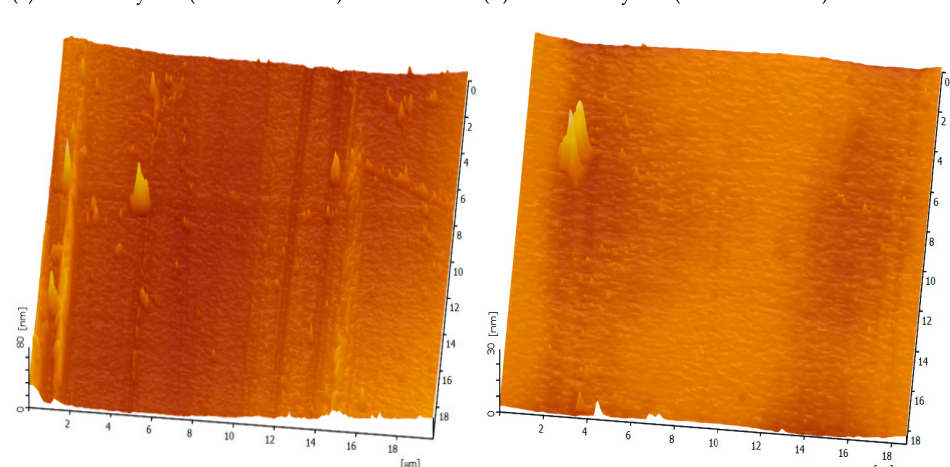
Figure 11. AFM morphology of 48-h PSVBA brushes grafted on flat silicon wafers at different wear stages. RMS—root-mean-square roughness. stages. RMS—root-mean-square